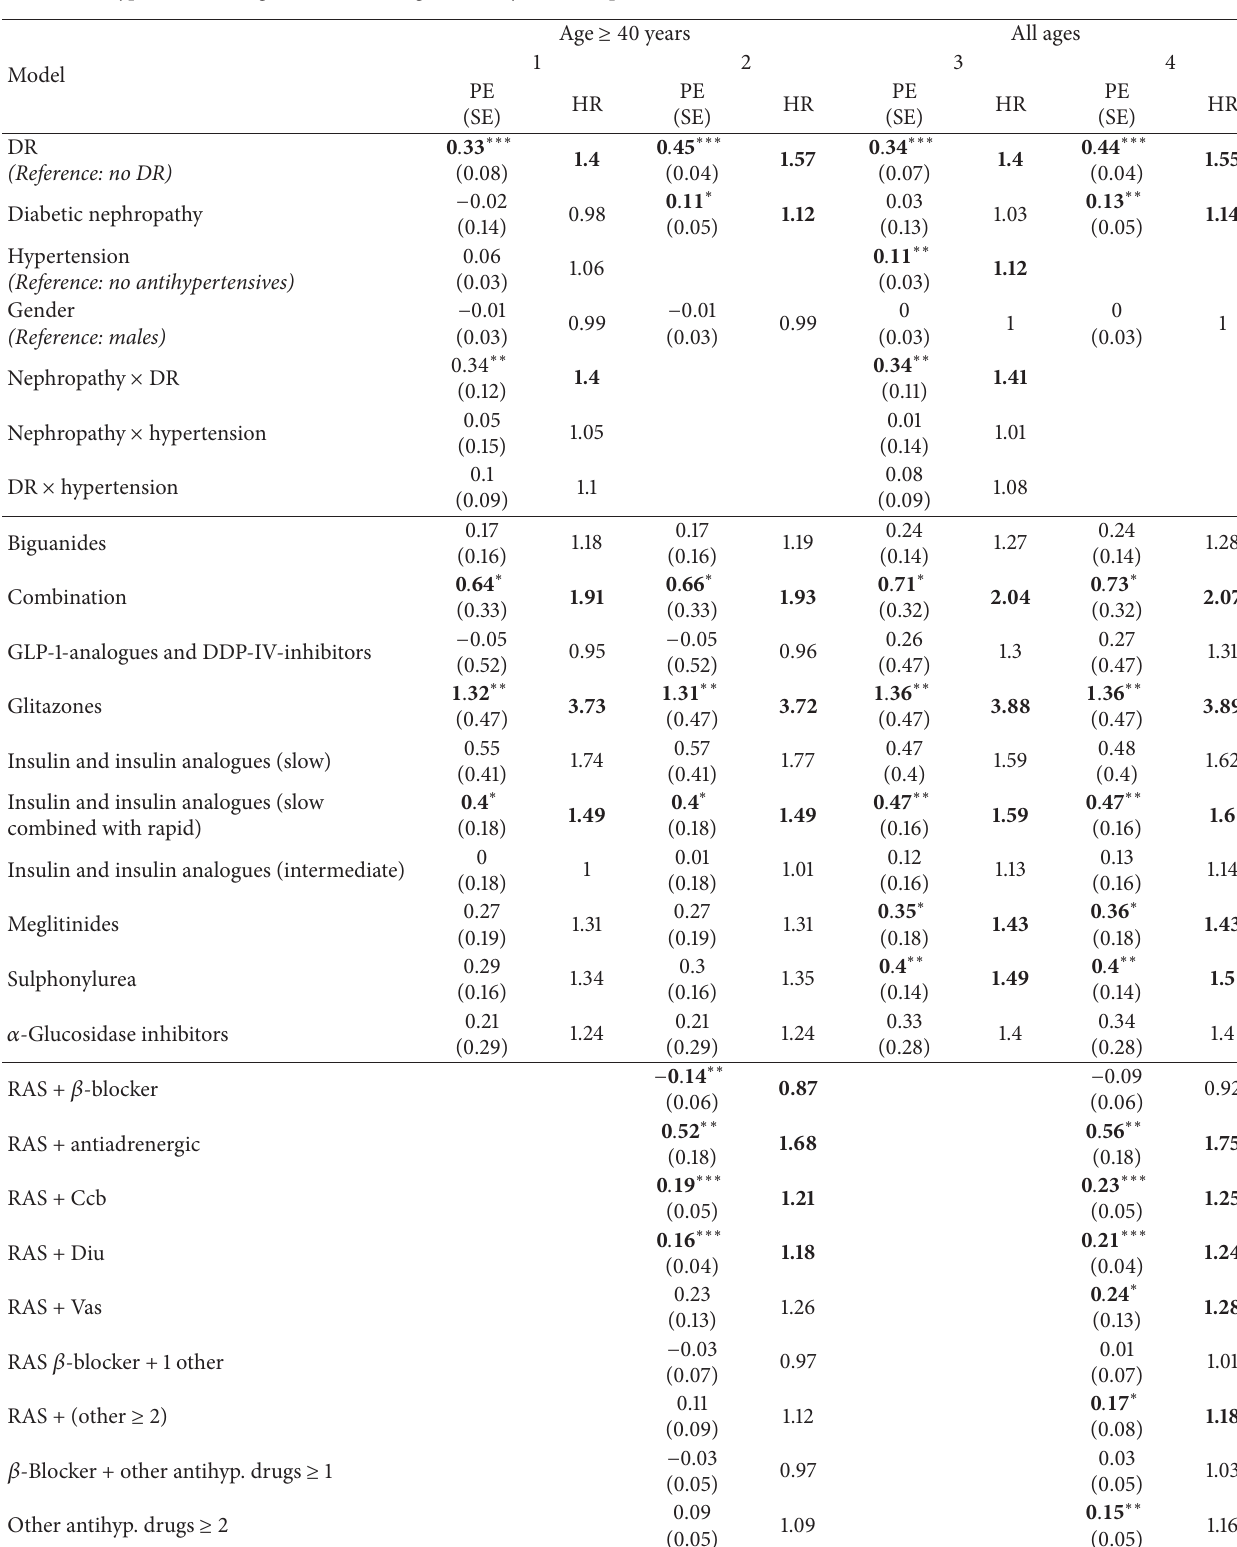
Table 2: Multivariable Cox regression model analyses showing the hazard ratios for glaucoma by antidiabetic drugs used in patients with DM. The effect of complications such as diabetic retinopathy and nephropathy was investigated, as well as the concomitant medications